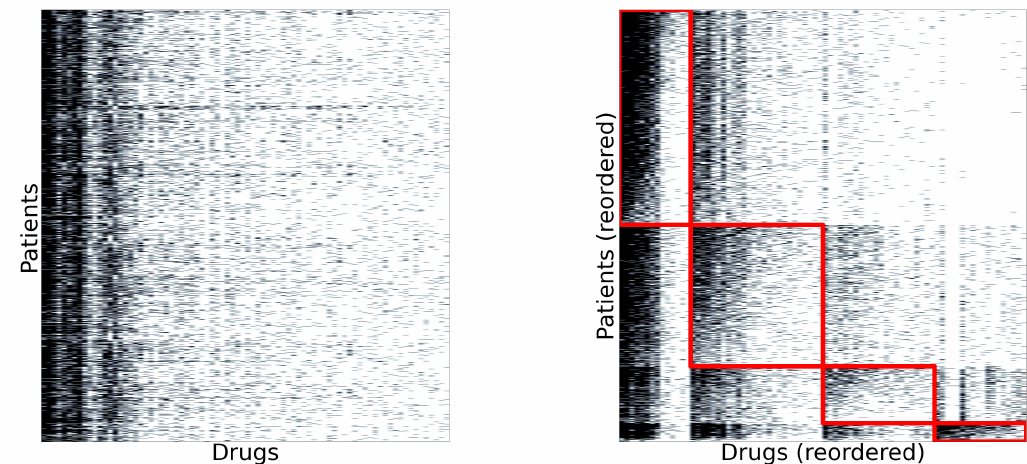
Figure 13. ( Left ) Original patient-drug matrix. ( Right ) Biclusters found by the co-clustering Figure 13. Left: Original patient-drug matrix. Right: Biclusters found by the co-clustering algorithm.